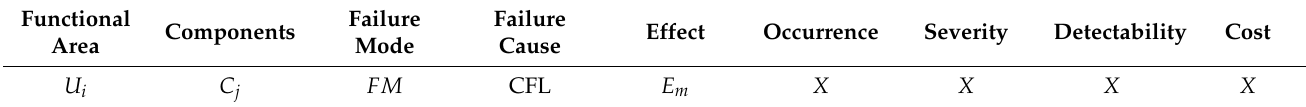
Table 1. Problem formulation.